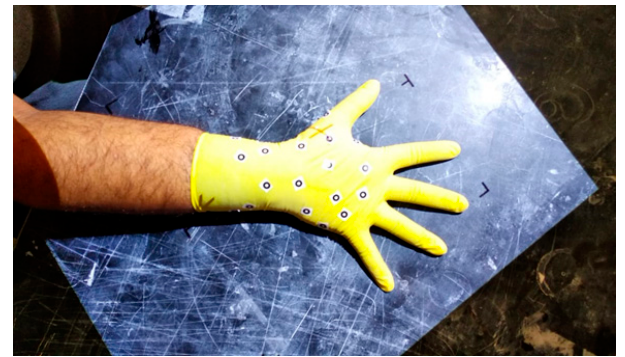
Figure 2. Hand being 3D scanned.